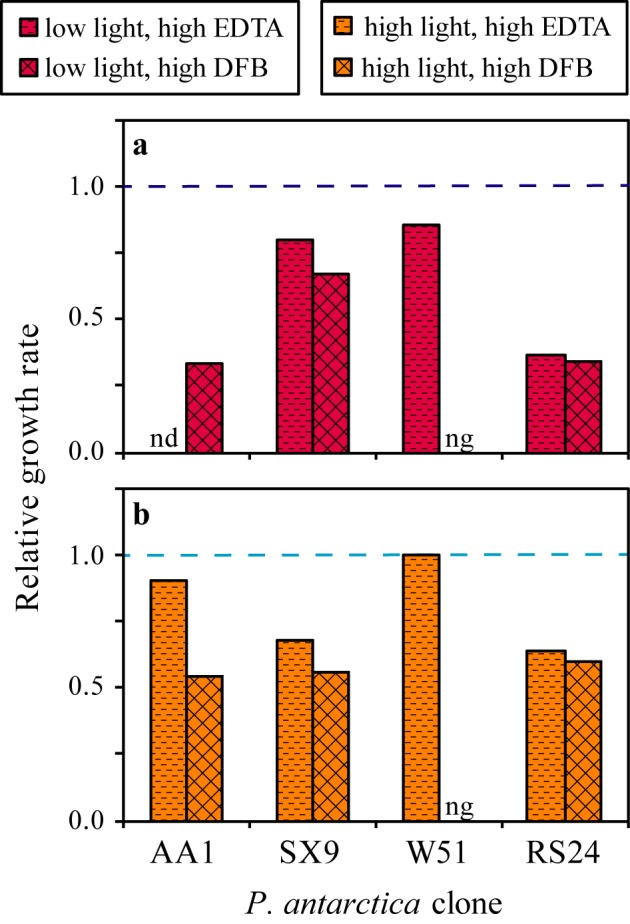
Extent of iron limitation in the high EDTA and DFB media differs among clones.The relative growth rates are the growth rates of the clones in the high EDTA or high DFB treatment divided by their growth rates in the iron replete treatment at low (a) and high (b) light. The dashed line (relative growth rate = 1) represents the normalized growth rate of each clone in the iron replete medium. For clone W51, “ng” (no growth) indicates that the clone did not grow in the high DFB medium. For clone AA1, “nd” (no data) were collected for the high EDTA medium at low light. This figure shows that, among the four clones, the extent of iron limitation under growth at low Fe′ is not related to the extent of iron limitation under growth on DFB-bound iron. This is particularly evident when comparing clone W51, which is iron replete in the high EDTA medium but does not grow in the high DFB medium, to the other clones. The data from clone AA1 have been published previously (Strzepek et al. 2011 [high light], Strzepek et al. 2012 [low light]).